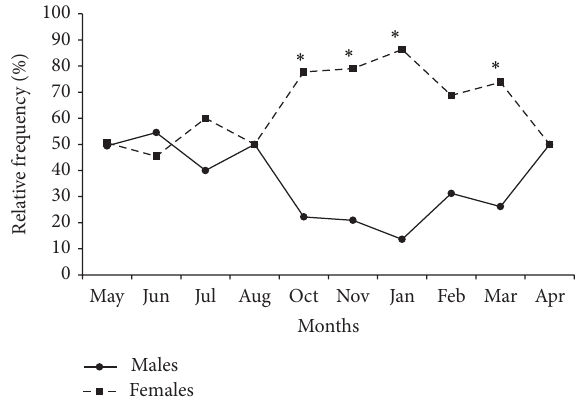
Figure 2: Monthly sex ratio of H. brasiliensis . ∗ Significant difference of the observed sex ratio from the expected 1: 1 ( 𝑁 males = 160; 𝑁 females =